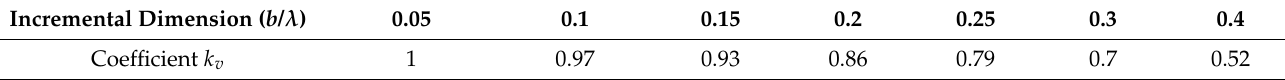
Figure 3. The graph of linear load coefficients from waves 𝜃 𝑥𝑖 ( a ) and 𝜃 𝑥𝑣 ( b ) under condition of 𝑑/  : (1) 0.1; (2) 0.15; (3) 0.2; (4) 0.3; (5) 0.5; (6) 1; (7) 5 and  /ℎ = 40 — continuous line;  /ℎ = 8 – 15 — dashed line [15]. At the moment, there are many regulatory documents (ISCS [16], SNiP [17], Stand- ards of Gazprom [18], API, CAN/CSA, DNV, Elforsk rapport 09:55, LG, ISO, EM), which determine the estimated value of the ice load. To simplify the calculation of the ice load, the standard methods of calculation were mathematically optimized [19]. The load from